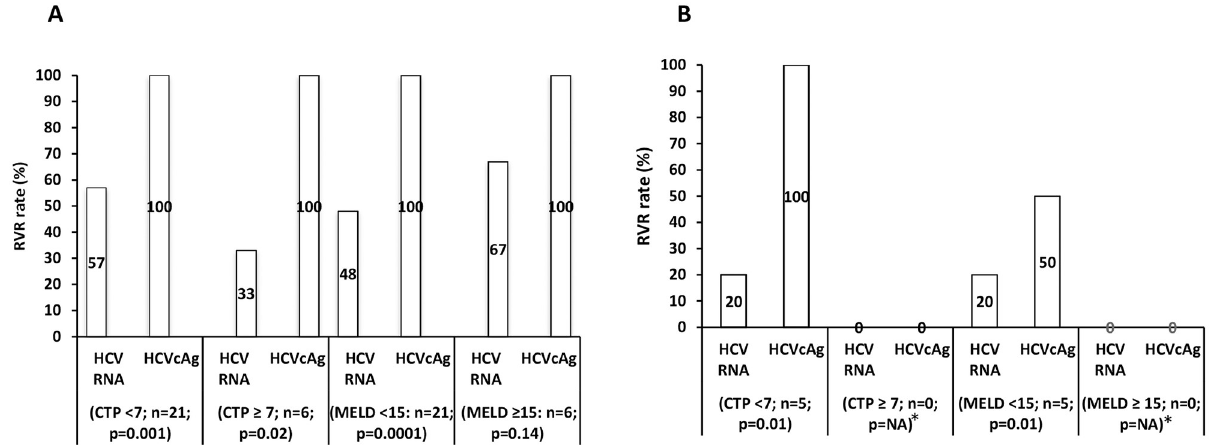
Fig 8. RVR rate based on CTP & MELD scores. (A) Treatment-na ï ve. (B) Previously treated. Abbreviations: HCV, hepatitis C virus; RNA, ribonucleic acid; HCVcAg, RVR, rapid virological response; hepatitis C virus core antigen; CTP, child-turcotte-pugh; MELD, model for end stage liver disease; � NA: not